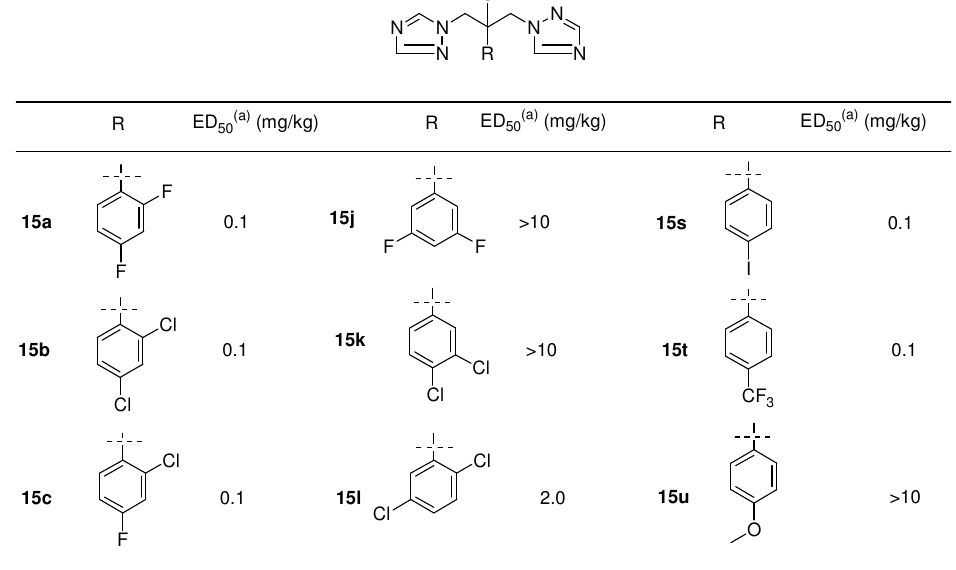
Table 5. Structures and in vivo activity of 1,3-bis-triazolyl propan-2-ols in the murine systemic candidiasis model